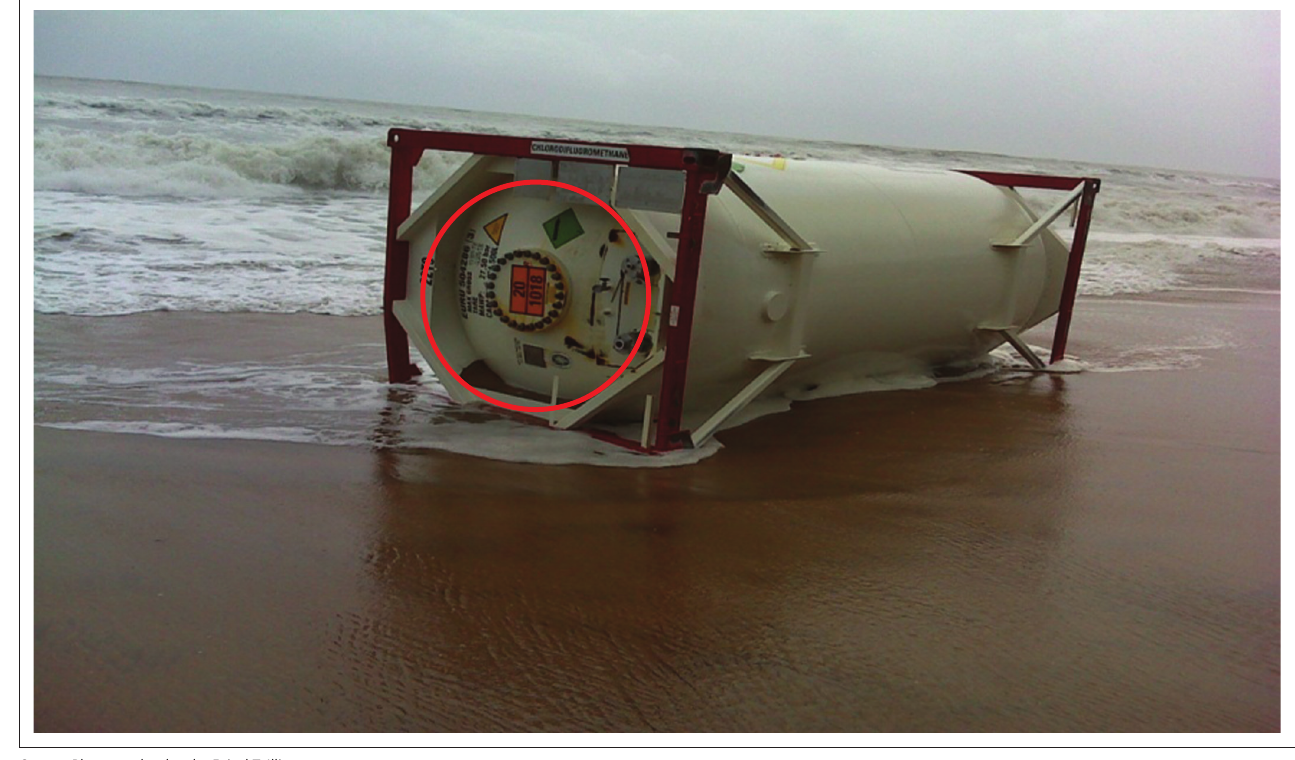
Source : Photograph taken by Faisel T. Illiyas FIGURE 3: Container at Jenma beach. Emergency Information Panel including coloured symbol can be seen inside the red